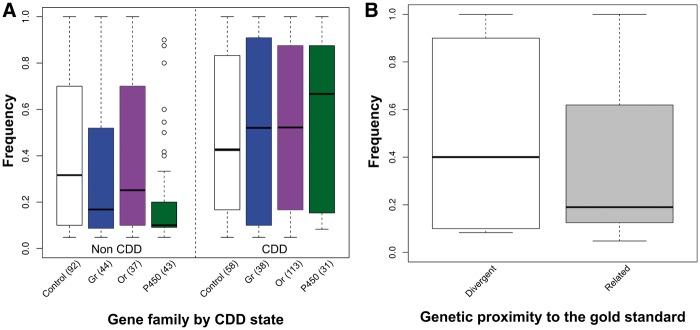
Frequency of CN ≠ 1 within races. (A) Frequency per gene family by category of CDD. (B) Frequency per category of genetic relatedness to the standard.